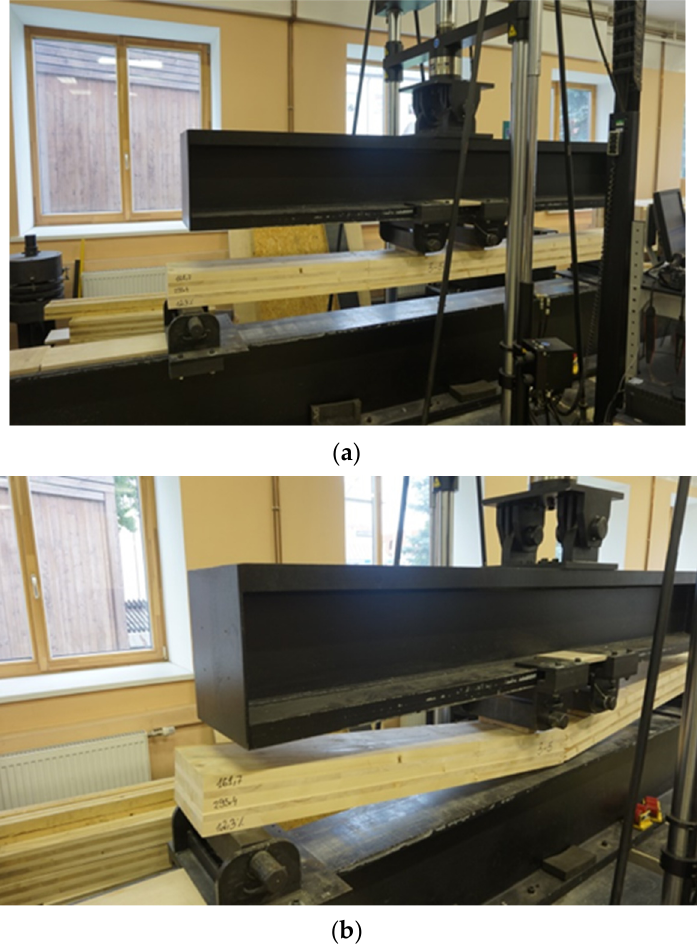
Figure 2. Measuring equipment for determining flexural strength: ( a ) view; ( b ) close view.